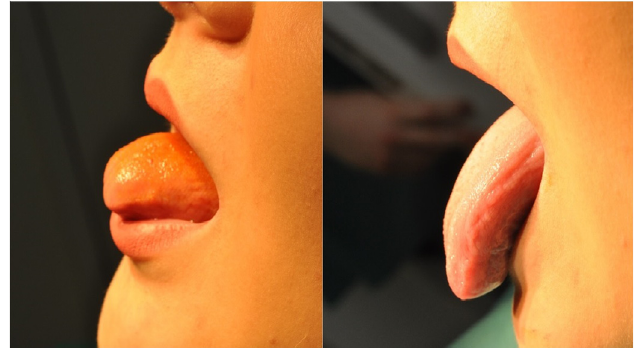
Fig. 1. Lingual protrusion limited by a short lingual frenulum (right photograph) and the protrusion immediately after surgery (left photograph).